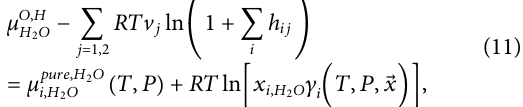
FIGURE 1 | Schematic diagram of experimental apparatus for hydrate reaction. Hydrate cores were not used in this manuscript, and the con fi ning pressure regulation system and axial pressure regulation system for core deformation test was not